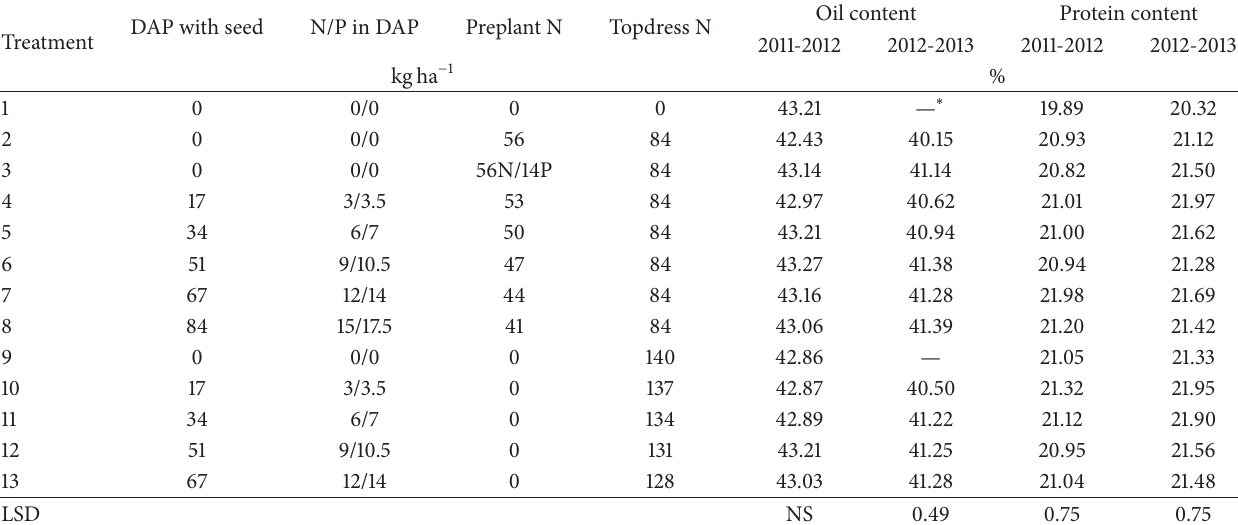
Table 4: Oil and protein content of canola as influenced by seed-placed diammonium phosphate (DAP) and nitrogen (N) application method in 2011–2013.